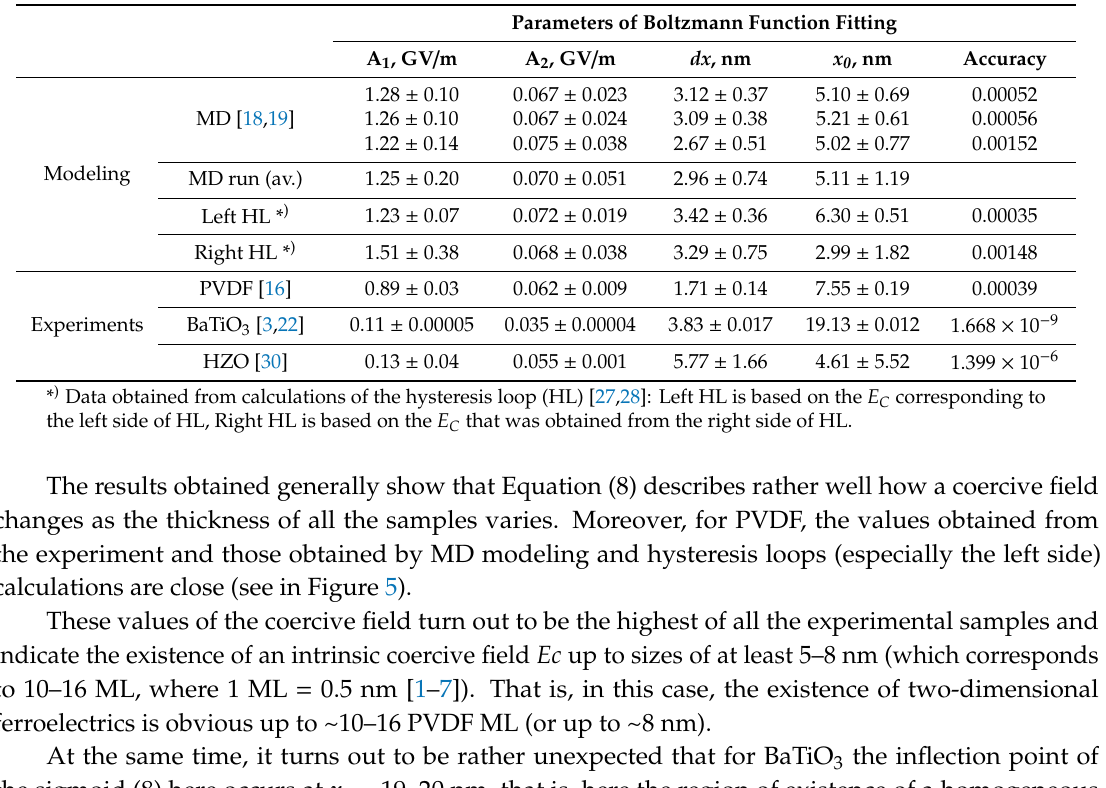
Table 1. Fitted parameters of the Boltzmann function for various nanoscale ferroelectrics in comparison with modeling and calculations using MD runs and hysteresis loop